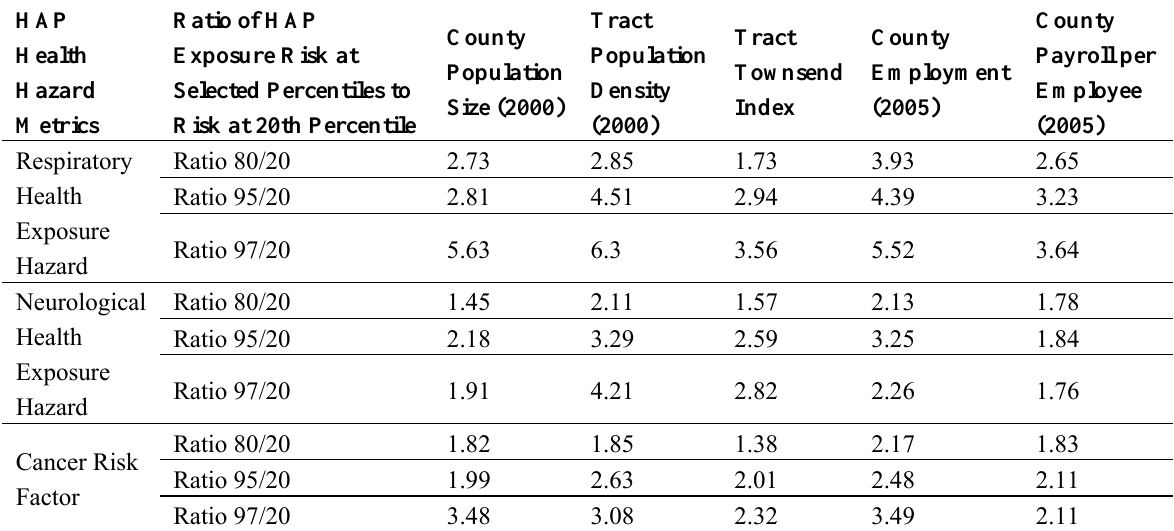
Table 2. The Social Gradient in HAP Exposure Hazard in U.S. (2005): Risk Ratios of 97th, 95th, and 80th Percentile to the Lowest Decile of Tract Population Size, Density, Economic Activity and SED.